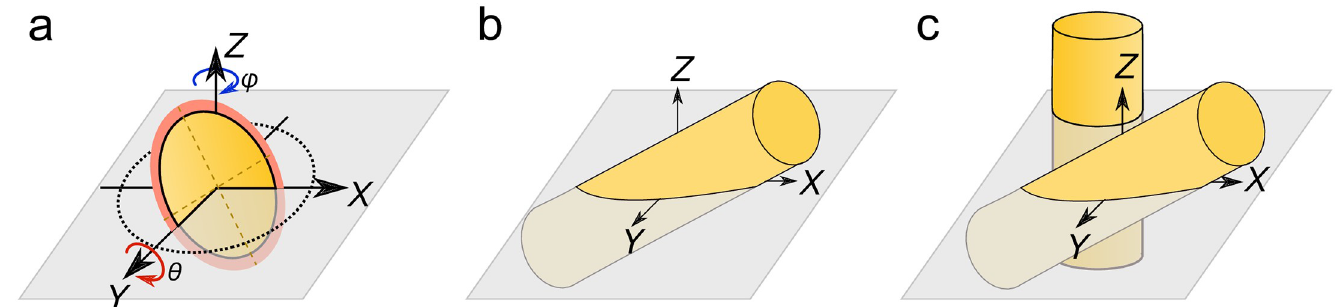
Fig 3. The synthetic fiber generation process: a) the cross-section rotation in a plane of the 3D volume, the orange region represents a gap for a given fiber; b) the cross-section propagation along the specified direction to form a fiber; c) adding the fiber into the 3D volume.